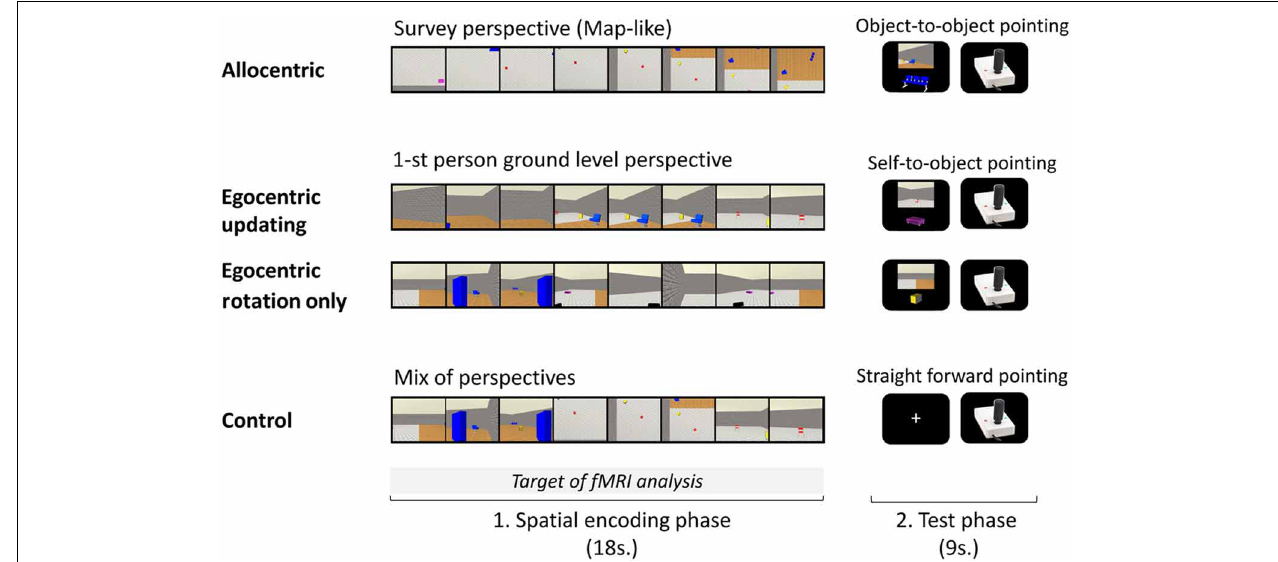
FIGURE 1 | A trial of each experimental condition performed during the experimental phase inside the MR imager is presented. Each of the four conditions, A, Allocentric; EU, Egocentric-updating; ERO, Egocentric with Rotation Only; and C, Control; was divided into an encoding phase and a test phase. In the encoding phase, participants saw a presentation of the environment’s layout: (A) from a survey